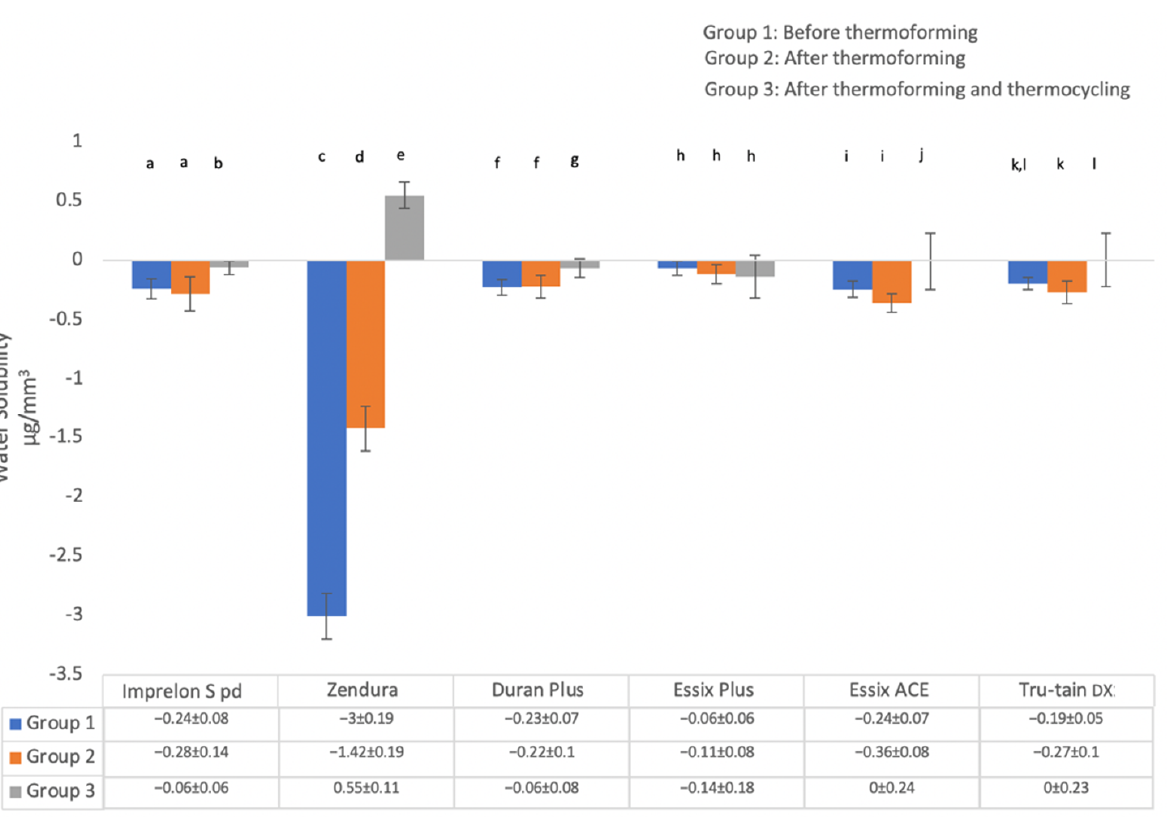
Figure 6. Comparison of the water solubility between the groups. Groups with similar small letters have no significant difference at ( p < 0.05).